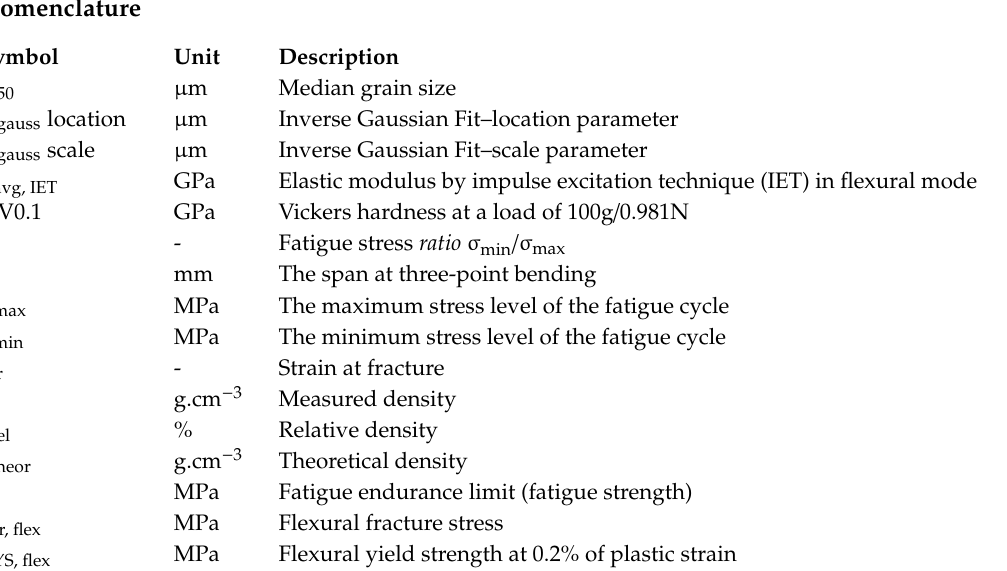
Figure 6. Fatigue crack initiation sites and deformation structure near the fracture initiation sites. ( a ) Fatigue crack initiation site is marked by dashed line and arrows, HEA 5, SEM, BSE; ( b ) fatigue crack initiation site is marked by dashed line and arrows, HEA 10, SEM, BSE; ( c ) detail of initiation site, HEA 5, SEM, BSE, the large grain(s) are marked by the dashed line, arrows indicate microcracks; ( d ) detail of initiation site, HEA 10, SEM, BSE, the large grain(s) are marked by the dashed line, arrows indicate microcracks; ( e ) fatigue crack initiation site in HEA 5, STEM, bright field, selected nano-size twins are indicated by arrows; ( f ) fatigue crack initiation site in HEA 10, STEM, bright field, selected nano-size twins are indicated by